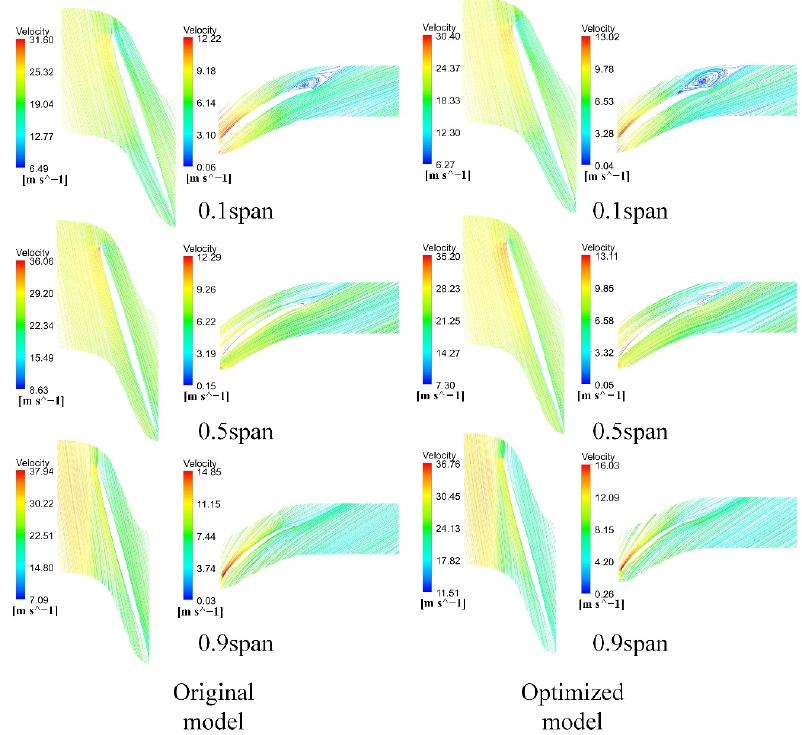
Figure 17. Streamline distribution of impeller and guide vane before and after optimization under the water condition.